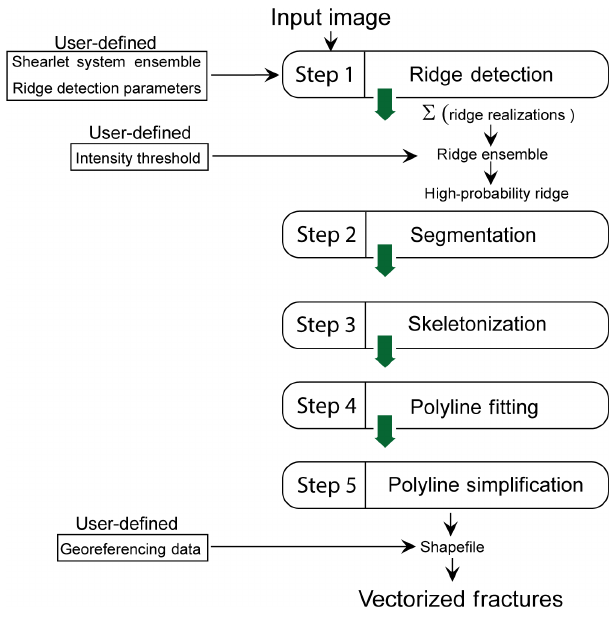
Figure 1. The automated fracture trace detection